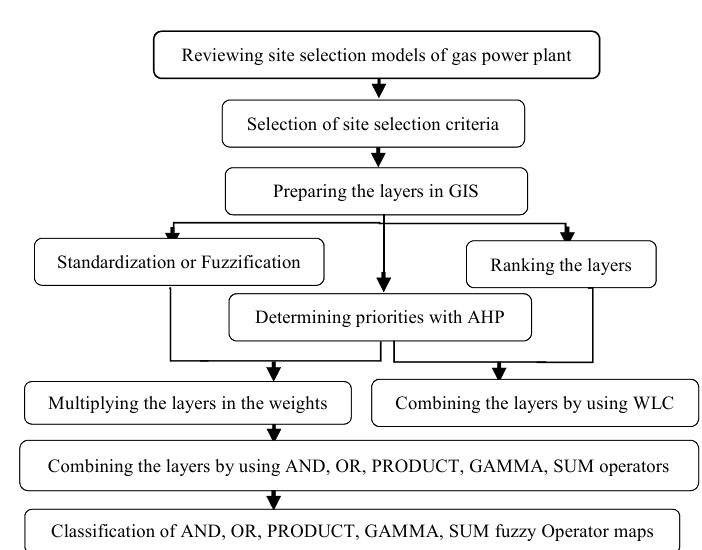
Fig 1: Location of Natanz City, the study area, on the map